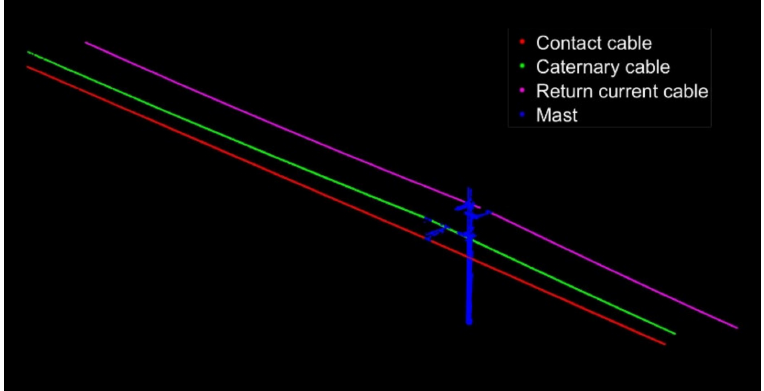
Figure 16. Fine classification results of the OCS point cloud with a length of 50 m.